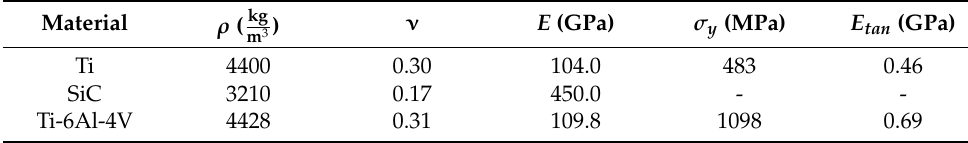
Table 4. Material model parameters of Ti, SiC, and